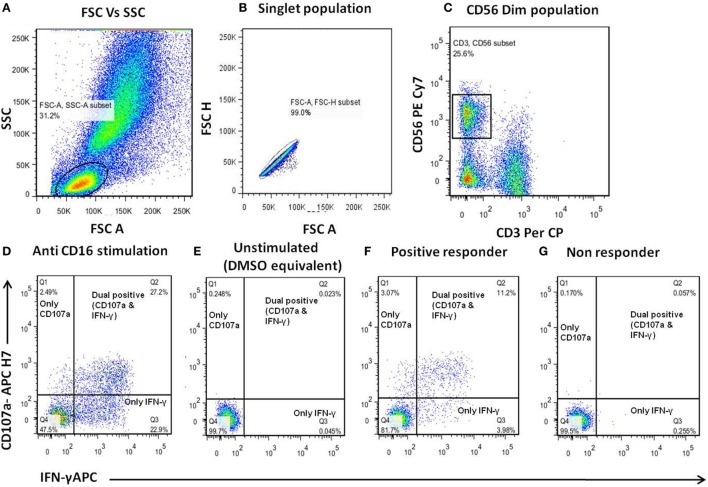
Gating strategy for antibody-dependent natural killer (NK) cell activation assay. (A–C) Donor blood (as a source of NK cells) was incubated with the serum/plasma test samples and human immunodeficiency virus (HIV) peptide pools for 5 h and then analyzed by flow cytometry. The lymphocytes were gated using FSC/SSC scatter. The NK cells were identified as CD3−CD56+ cells and assessed for surface CD107a expression and intracellular IFN-γ expression. (D) Representative dot plots for positive control (purified anti-CD16). (E) Unstimulated (DMSO equivalent solution) control. (F,G) Representative displays of ADCC responder (patient-1) and non-responder (patient-2) to HIV-1 Env-C peptide pool.